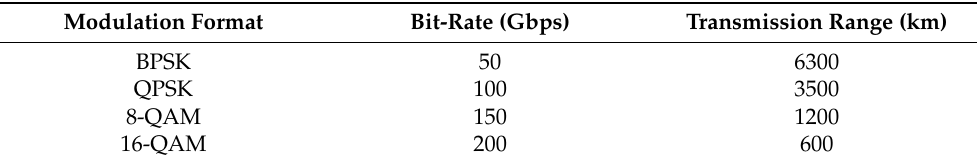
Table 1. Transmission distance and supported bit rate by a single transceiver